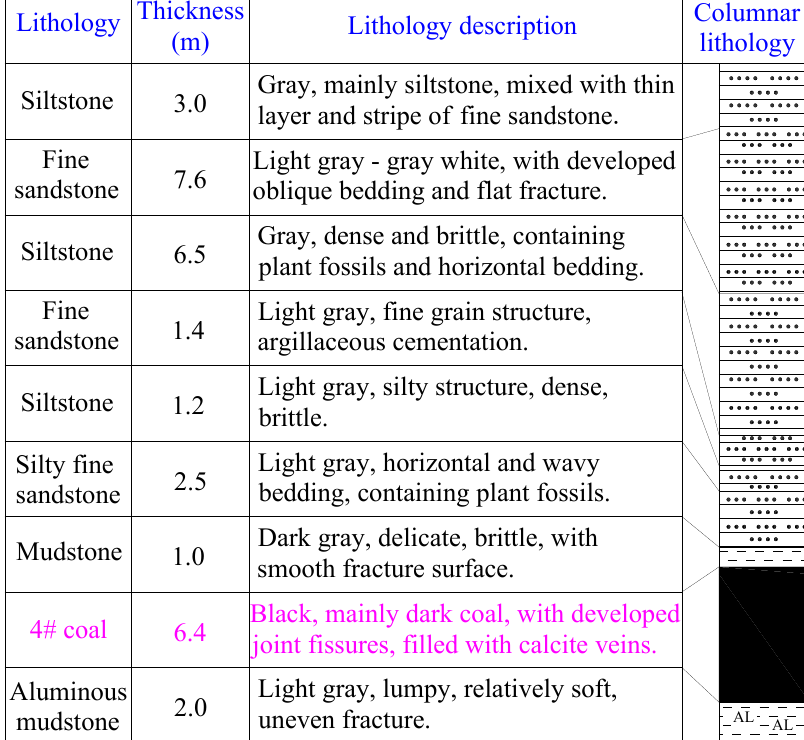
Figure 1. Occurrence conditions of the roof and the floor of the coal seam.